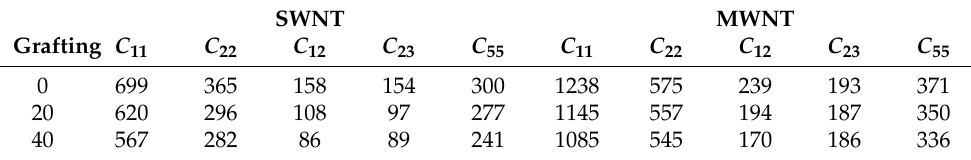
Table 4. Transversely isotropic elastic stiffness components of CNTs